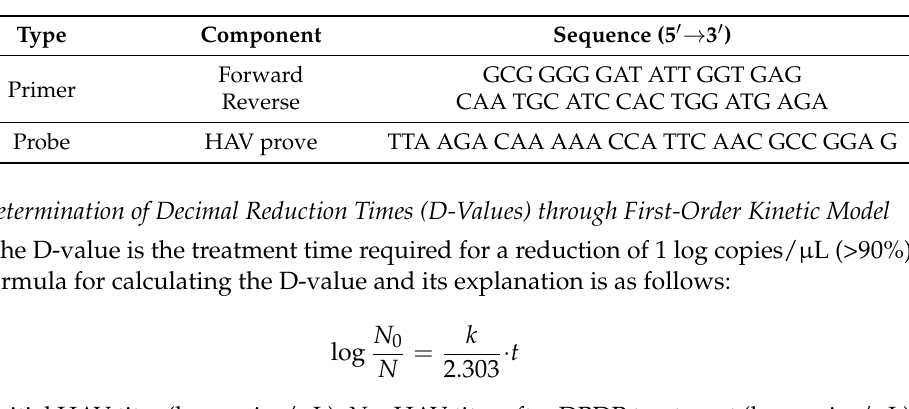
Table 1. Sequence of primers and probe for RT-qPCR to quantitate